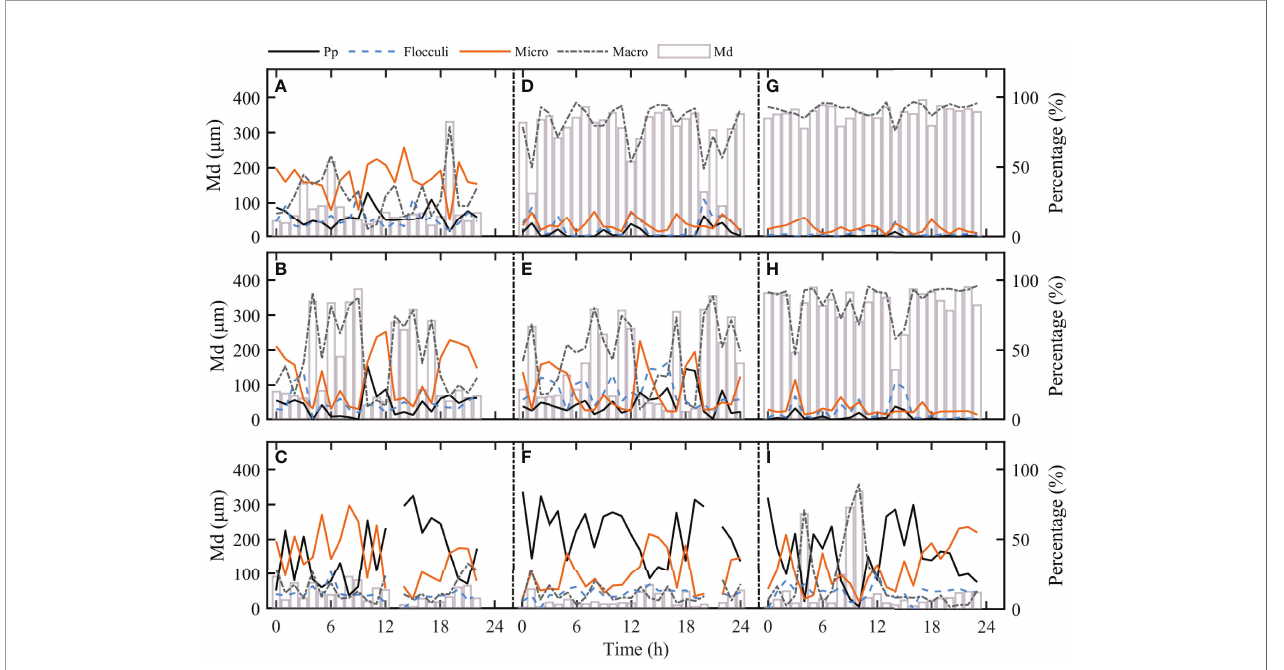
FIGURE 9 | Temporary variability of the fl oc size ( m m), volumetric percentage of Pp, Flocculi, Micro, and Macro in the surface layer (A, D, G) , middle layer (B, E, H) , and bottom layer (C, F, I) . The gray bar indicates the fl oc size based on the left scale and several broken lines; the black lines are Pp, the blue dashed lines are Flocculi, the orange lines are Micro, and the gray lines are Macro, all based on the right scale ( A – C, D – F, G – I represent the spring, middle, and neap tides,